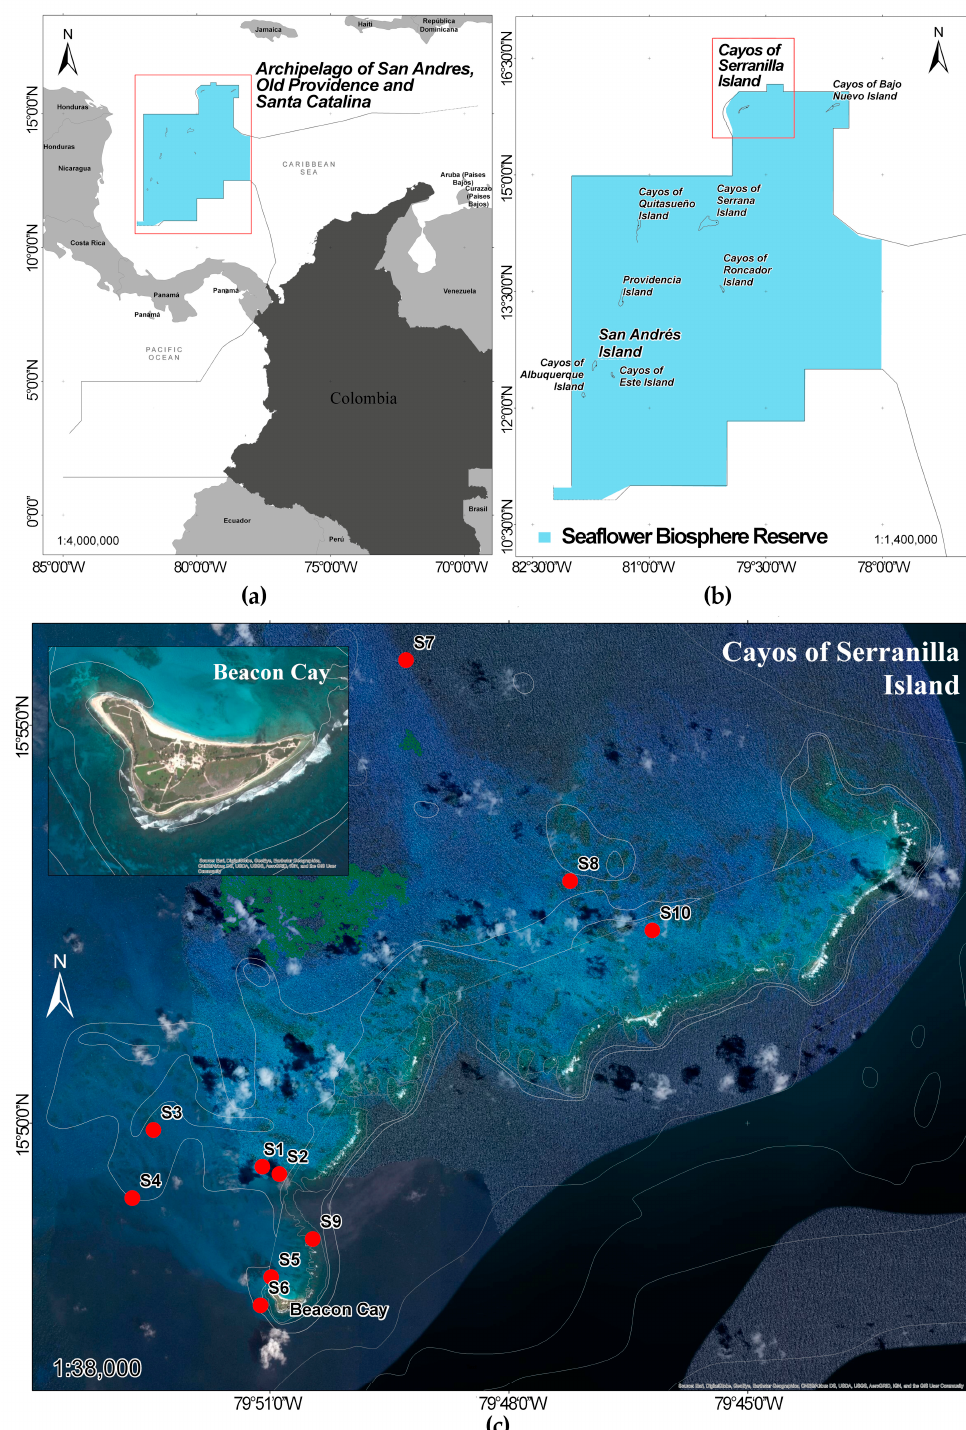
Figure 1. Maps showing the position of the study area: ( a ) the location of the Seaflower BR in the south west of the Caribbean, ( b ) map of the Seaflower BR showing the San Andres archipelago, including San Andr é s, Old Providence, and Serranilla island, and ( c ) the locations of the survey sites at Serranilla (red points: S1–S10) together with (inserted) an aerial image of Beacon Cay, the largest cay on Serranilla (top